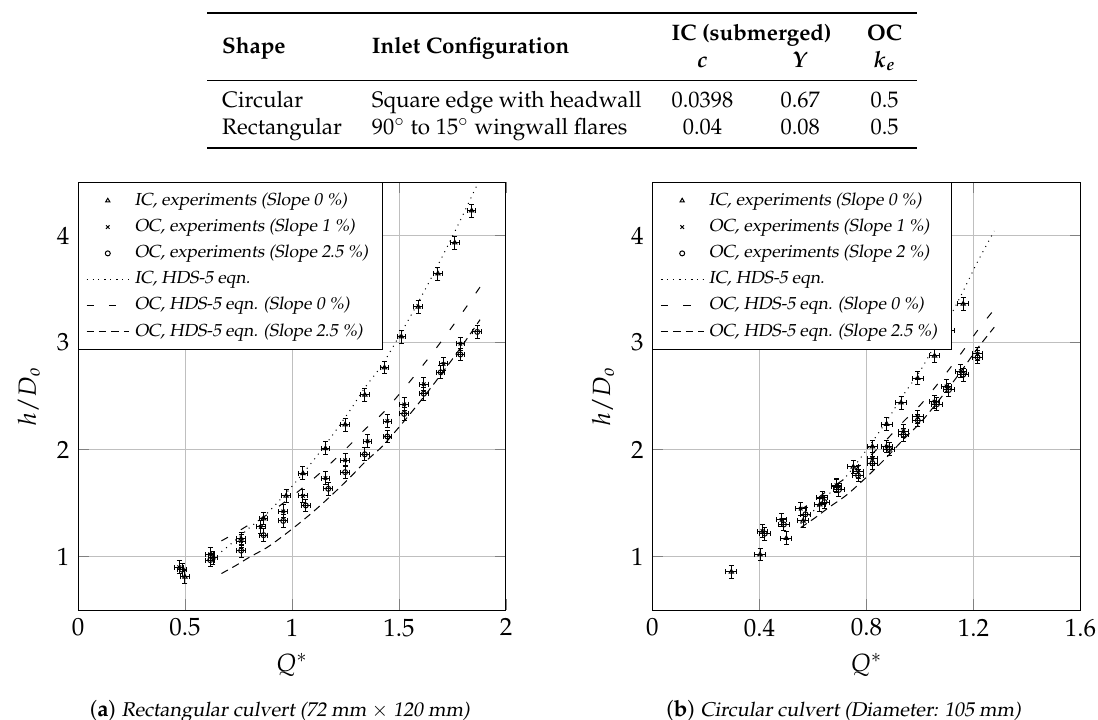
Table 2. Entrance loss coefficients for modeled culverts. c and Y are loss coefficients from the inlet control equation, k e is a loss coefficient from the outlet control equation.